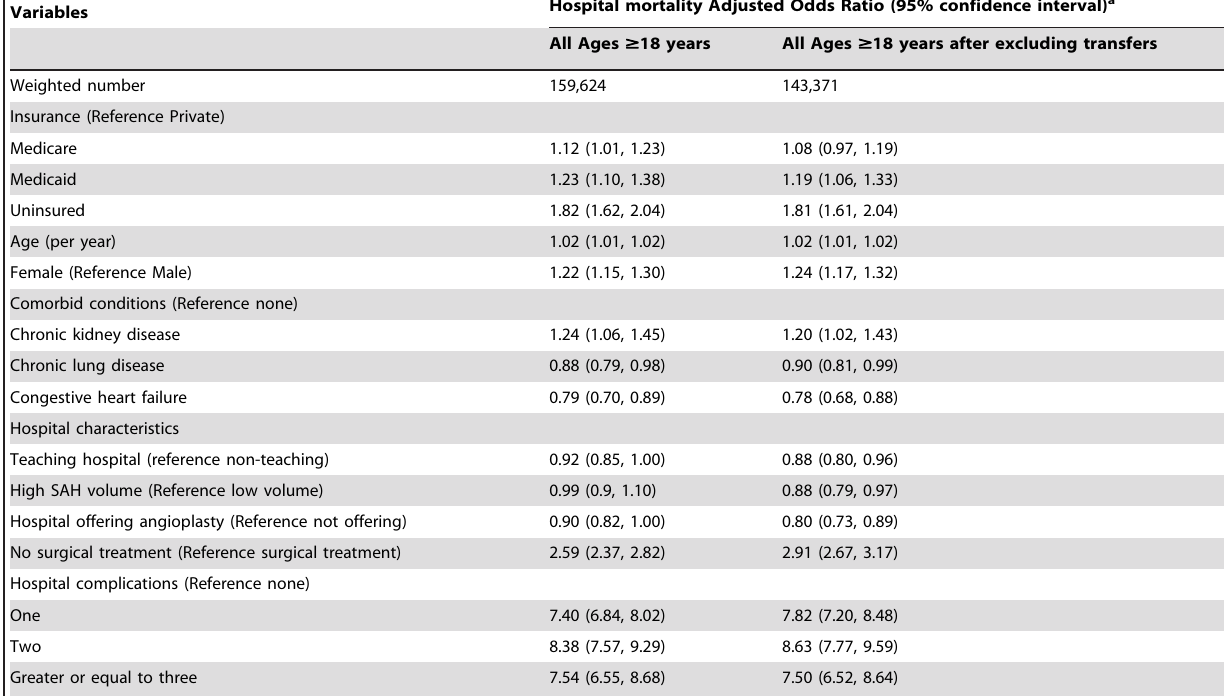
Table 3. Adjusted Odds of Hospital Mortality after Subarachnoid